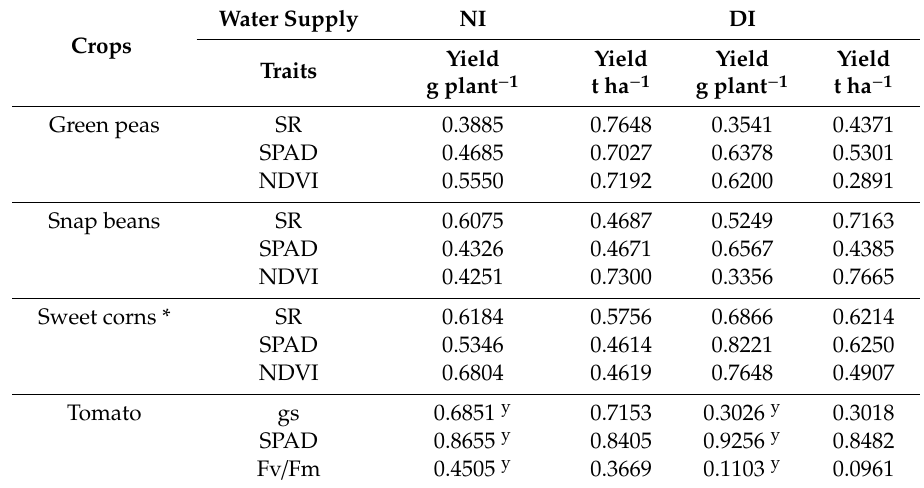
Table 4. Correlation coe ffi cients between physiological traits measured during flowering and yield under